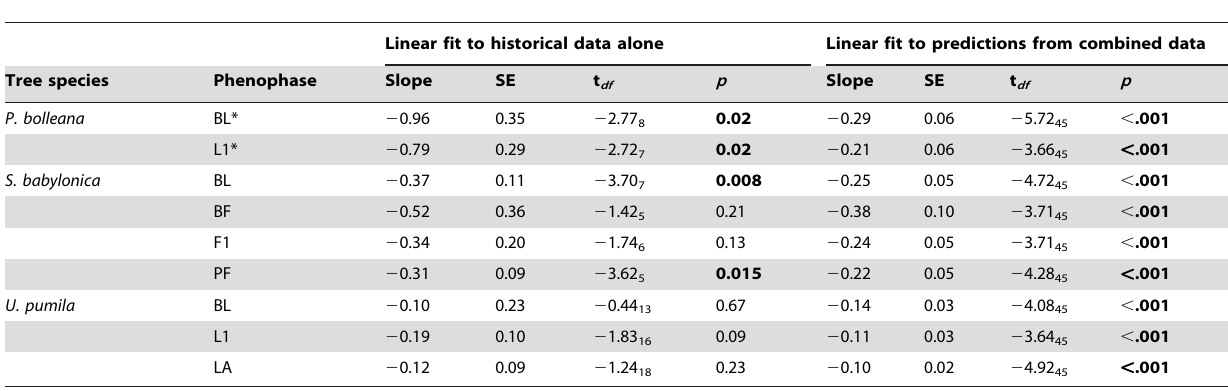
Table 4. Comparison of regression fits to historical data and to the time-series of predictions (1963–2009) from phenology models developed based on combined data.